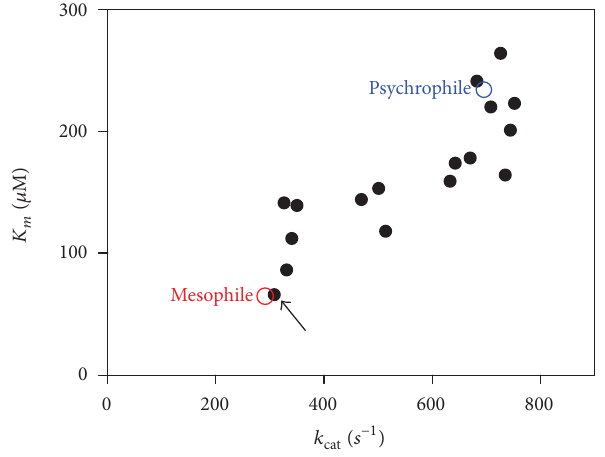
-amylase. is plot of the kinetic parameters for the stabilized mutants (�lled symbols) shows that the general trend is to decrease the activity and to increase the affinity for the substrate of the wild-type psychrophilic enzyme (open symbol). e most stable mutant bearing six additional interactions (arrow) displays kinetic parameters nearly identical to those of the mesophilic homologue (open symbol). Adapted from [189,